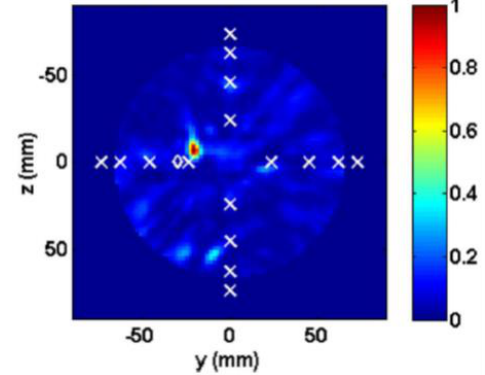
Figure 24. Reconstructed image of a breast phantom detection system developed by Porter et al. [80]. The tumour is indicated by the red spot; the x markers represent the positions of the antennas; and the diamond markers represent the actual location of the tumour centres. Reprinted with permission from